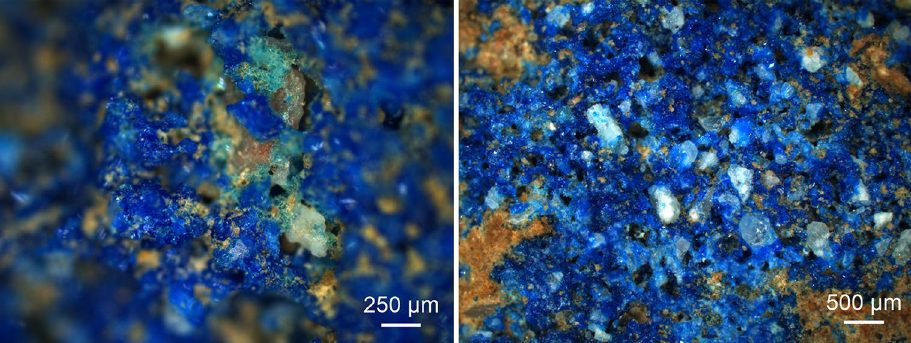
Figure 2. Darkfield light microscopy images of pigment balls unearthed in Aventicum (left; insulae 15) and Augusta Raurica (right). The left micrograph shows the green glass phase found as a by-product of the synthesis. Brown particles present in both images are due to adherent soil from the excavation sites (see Fig. S1 in the Supplementary Information for further micrographs).